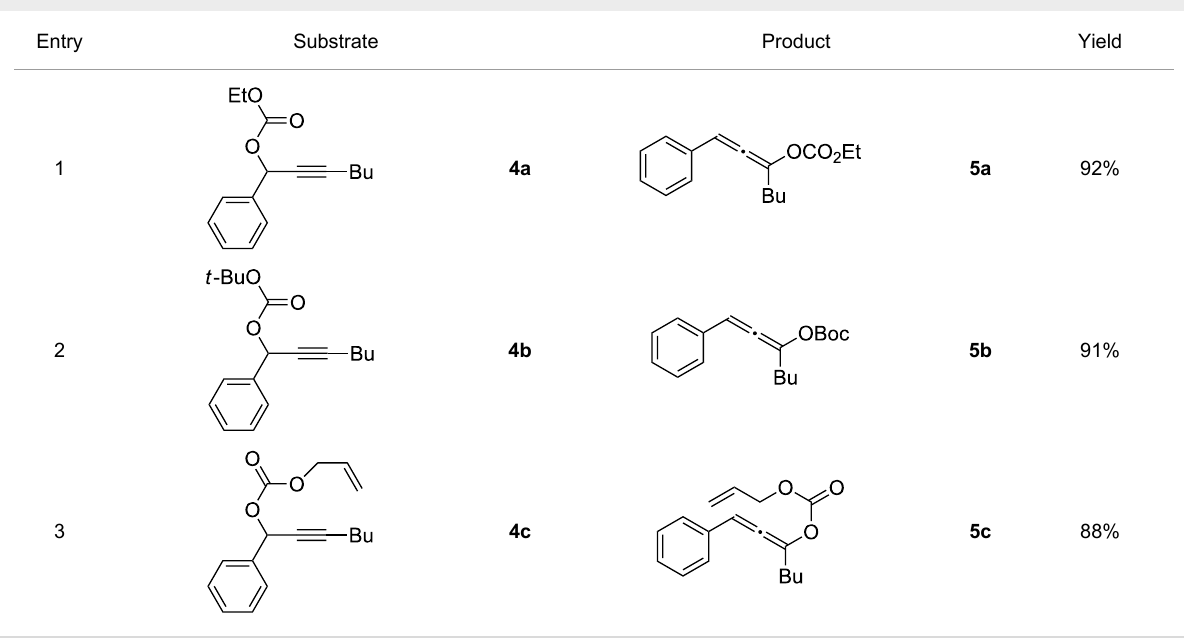
Table 2: Different migrating groups.